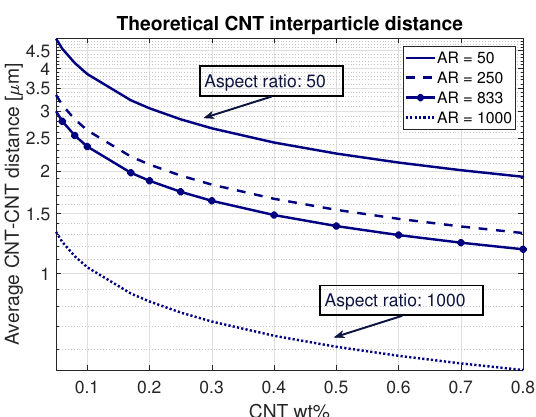
Figure 3. The theoretical average CNT interparticle distance for MWCNTs with AR = 1000. An- alytical results ( Φ pc and Φ av ) show a percolation threshold of 0.025 wt%. Numeral simulations give Φ sim = 0.15 wt%. Due to the agglomeration effects, experimental results give Φ pc = 0.8 wt%, corresponding to the results from Li et al. [1] with 10% agglomeration volume.